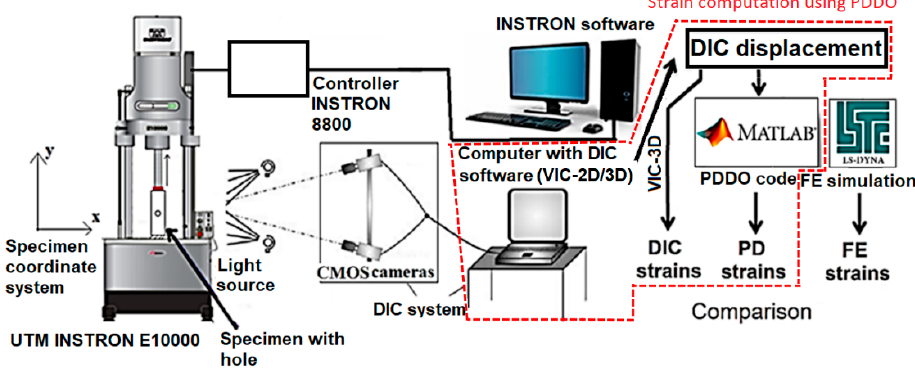
Figure 5. Schematic of the experimental-computational setup.